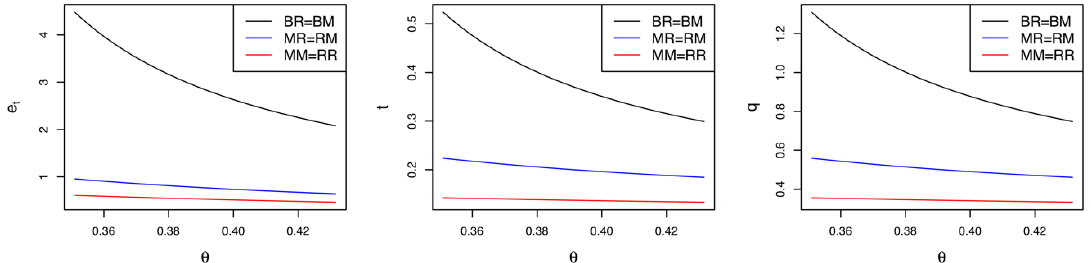
Figure 5. Comparisons of the green innovation effort, the collecting rate, and the market demand among the six game models.